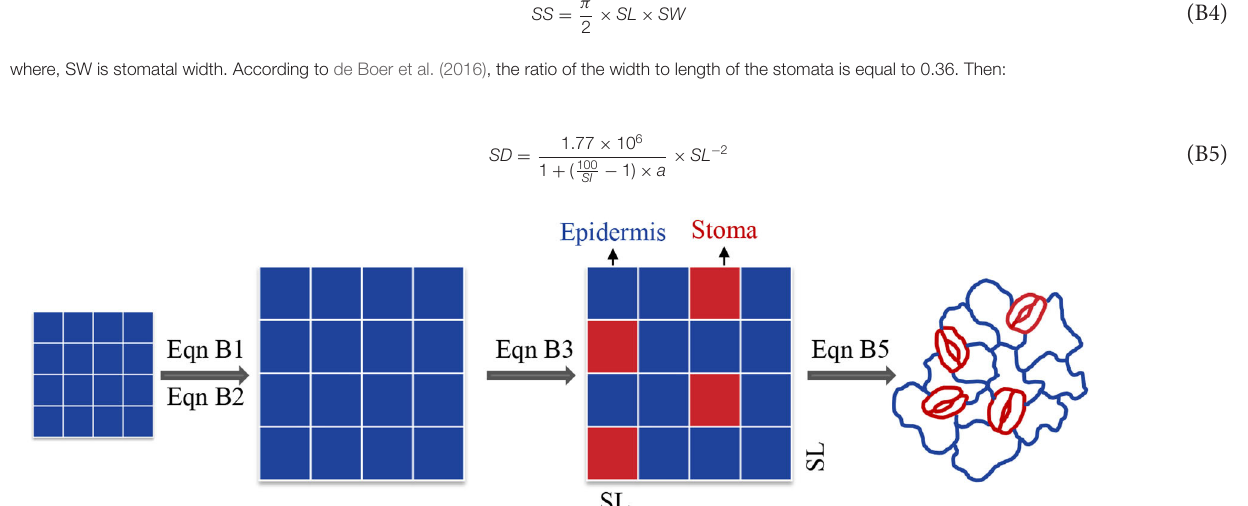
Figure B1| Analytical framework from square to actual stomata and formula transformation from Equation (B1) to Equation (B5).